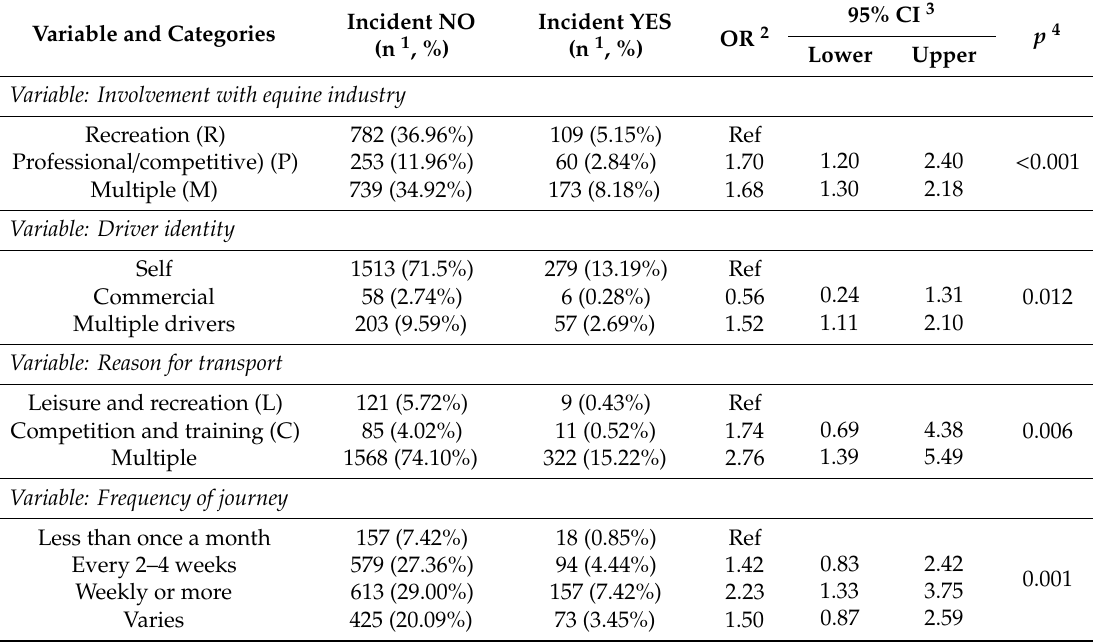
Table 6. Results of univariate logistic regression analyses of significant associations between variables (involvement with equine industry, main driver identity, reason for transport and frequency of journeys) and whether an incident was reported.